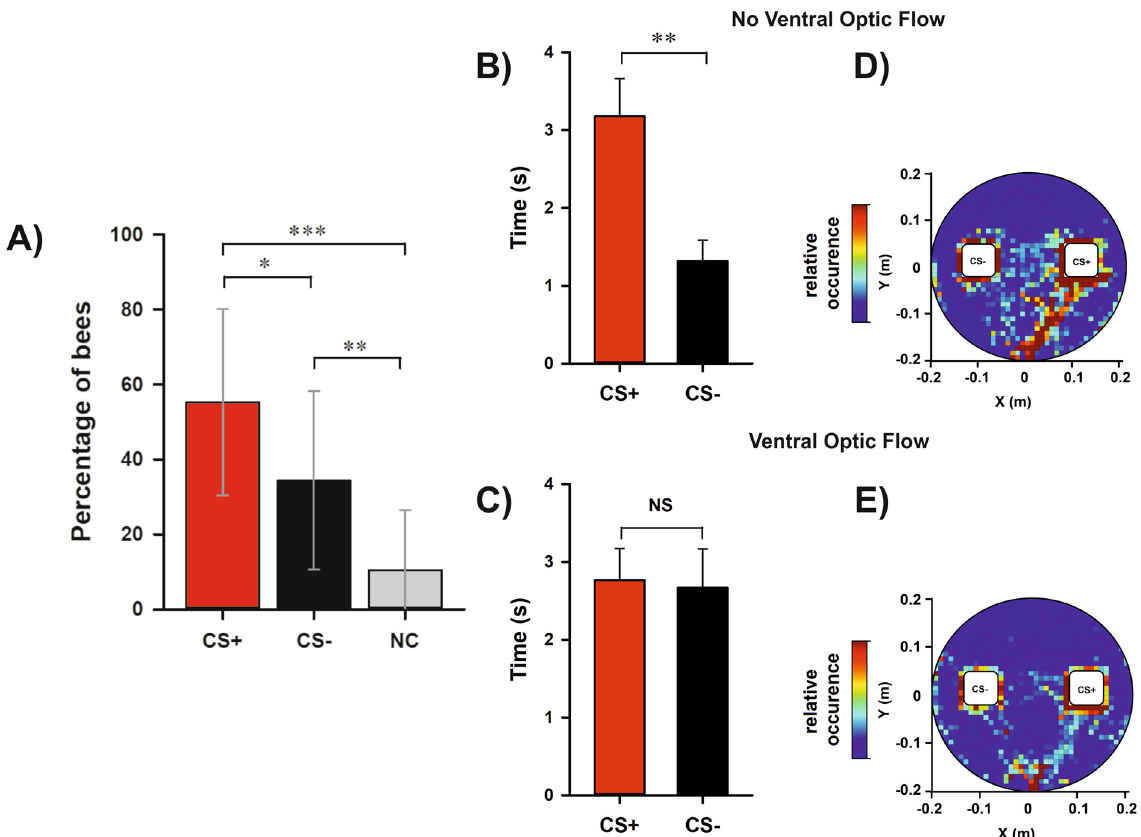
Figure 9. Test performances (1st choice and fixation time) in a color discrimination learning task under two different ventral optic-flow conditions (with ventral optic flow and without ventral optic flow). ( A ) 1st choice performed during the test. As there were neither significant differences between the two ventral optic-flow conditions nor between the color conditions (blue or green rewarded), results were pooled and presented as a single bar diagram (N = 67). The graph shows the percentage of bees responding to the CS+ (red), to the CS− (black) or not making any choice (NC; gray) during the retention test. Error bars indicate 95% confidence intervals. *: p < 0.05; **: p < 0.01; ***: p < 0.001. ( B , C ) Fixation time during the test in the ‘ No Ventral Optic Flow Condition ’ and in the ‘ Ventral Optic Flow Condition ’, respectively. In this case, fixation times were separated according to the experimental condition, as different response patterns were observed with and without ventral optic flow. The graphs show the mean time (± S.E.) spent fixating either the CS+ or the CS− during the retention test. ( B ) In the ‘ No Ventral Optic Flow Condition ’, bees fixated significantly longer the CS+ than the CS−. **: p < 0.01. ( C ) In the ‘ Ventral Optic Flow Condition ’, bees fixated equally the CS+ and the CS−. NS: not significant. ( D , E ) Heat maps showing the cumulative coordinates occupied by the bees during the test in the ‘ No Ventral Optic Flow Condition ’ and in the ‘ Ventral Optic Flow Condition ’, respectively. The CS+ is shown on the right by convention. Coordinates were binned into 1 cm 2 . Warmer colors depict locations more frequently occupied (see color bar). The highest frequency is cut down to 10% of the maximum on the color bar. ( D ) In the ‘ No Ventral Optic Flow Condition ’, bees clearly aimed at the CS+ besides choosing it more frequently in their first choice. ( E ) In the ‘ Ventral Optic Flow Condition ’, bees also aimed at the CS+ but in a less clear